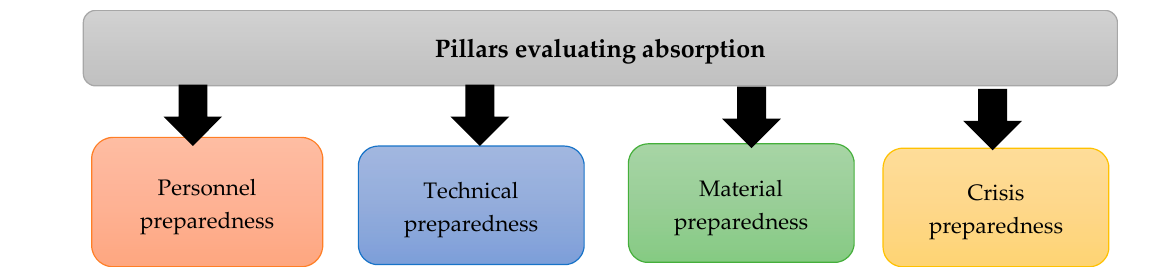
Figure 8. Pillars evaluating absorption.